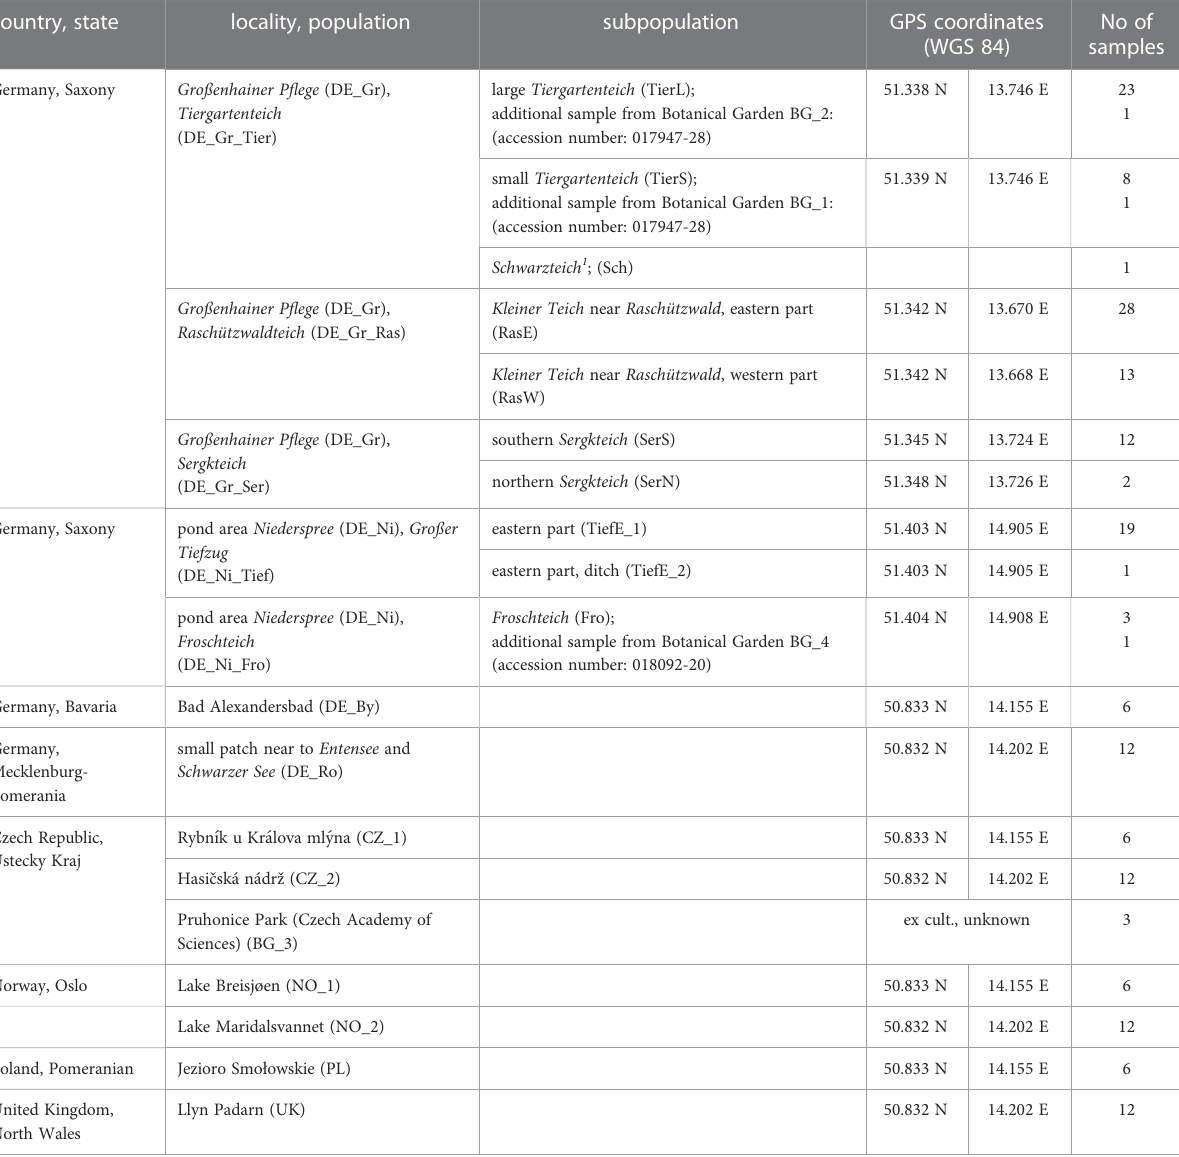
TABLE 1 Origin of sampled material. country, state locality, population subpopulation